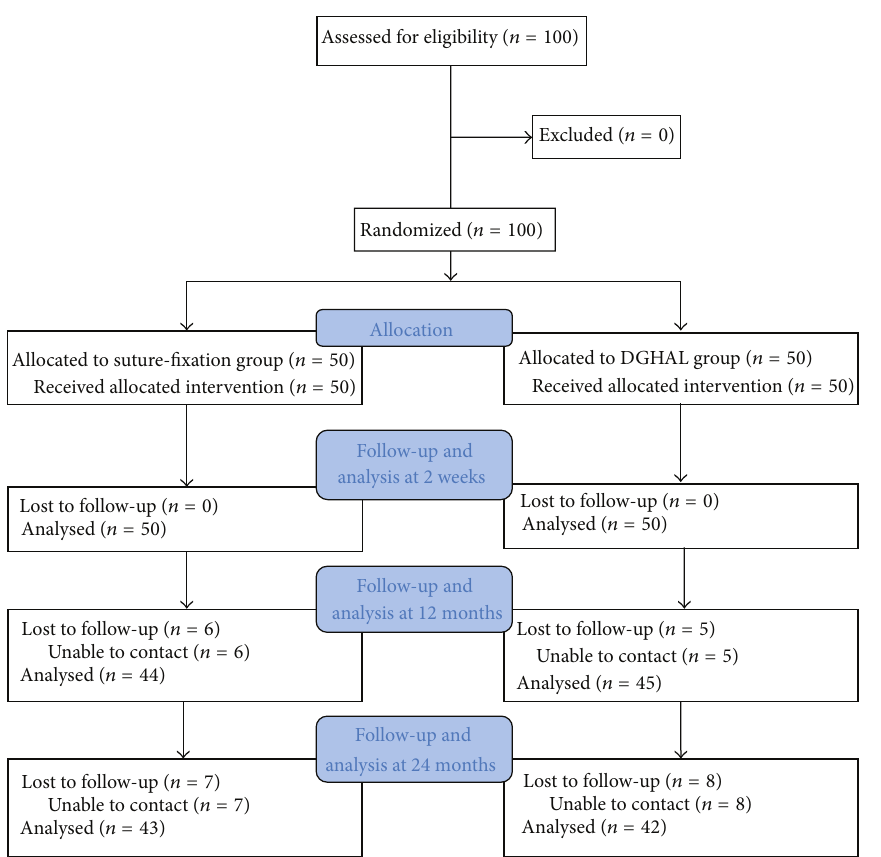
Figure 1: CONSORT flow chart of study enrollment. DGHAL: Doppler-guided hemorrhoidal artery ligation.